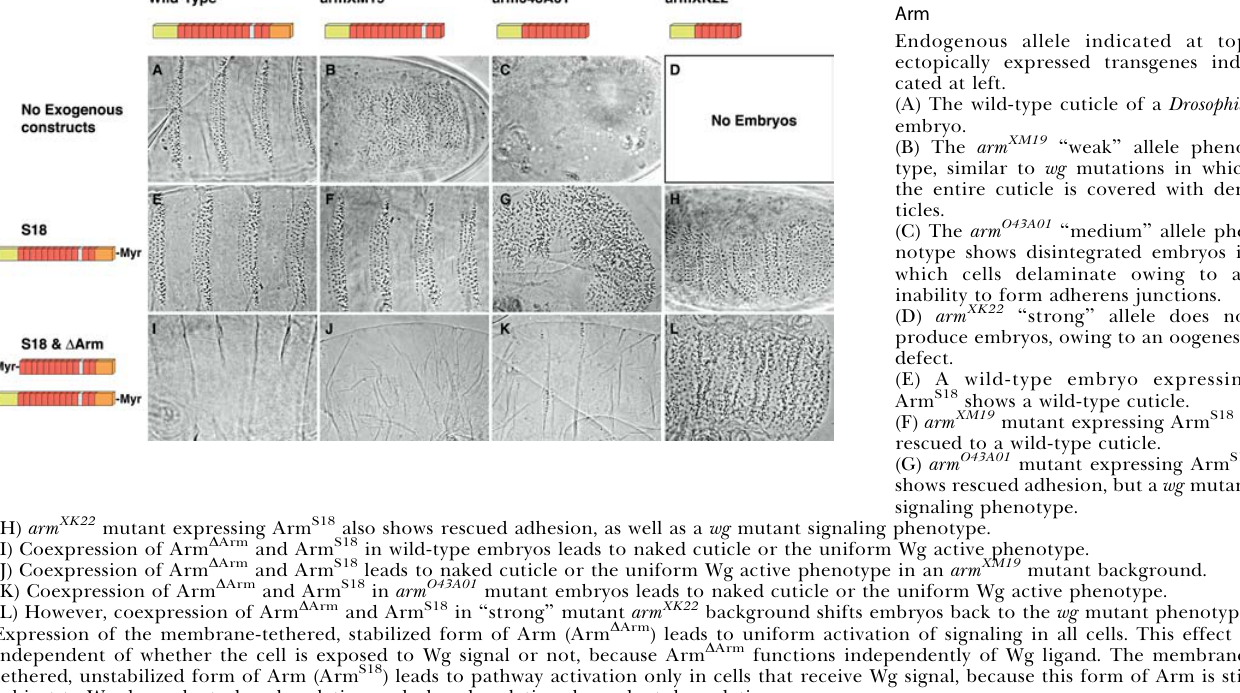
Figure 1. Arm D Arm Requires Endogenous Arm Endogenous allele indicated at top; ectopically expressed transgenes indi- cated at left. (A) The wild-type cuticle of a Drosophila embryo. (B) The arm XM19 ‘‘ weak ’’ allele pheno- type, similar to wg mutations in which the entire cuticle is covered with den-